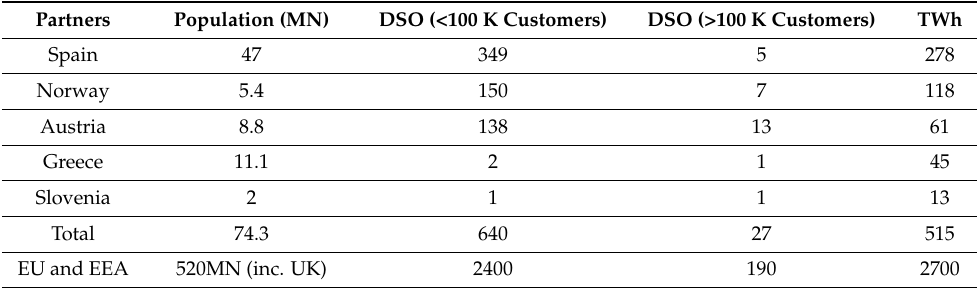
Table 7. Number of DSOs in partner countries and EU and EEA for RESOLVD replication and market. Partners Population